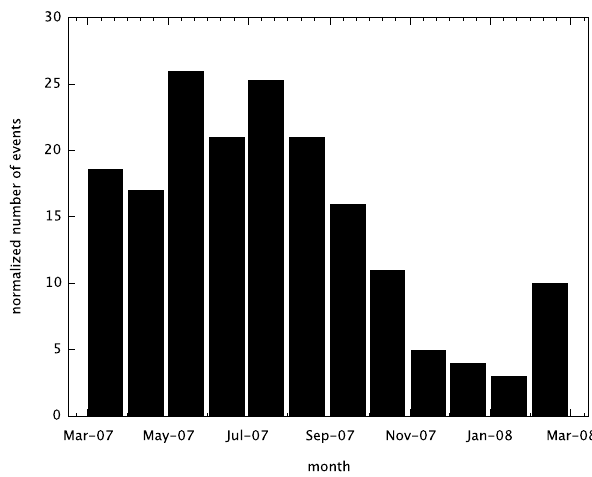
Fig. 10. Normalized monthly occurrence frequency of AGW-TID ( N e , T i , T e , and V i combined) signatures in ESR IPY data. The height of the bars tell the number of days with AGW-TID-signatures observed in each month, divided by the ratio of the number of days with ESR data to the total number of days within the same